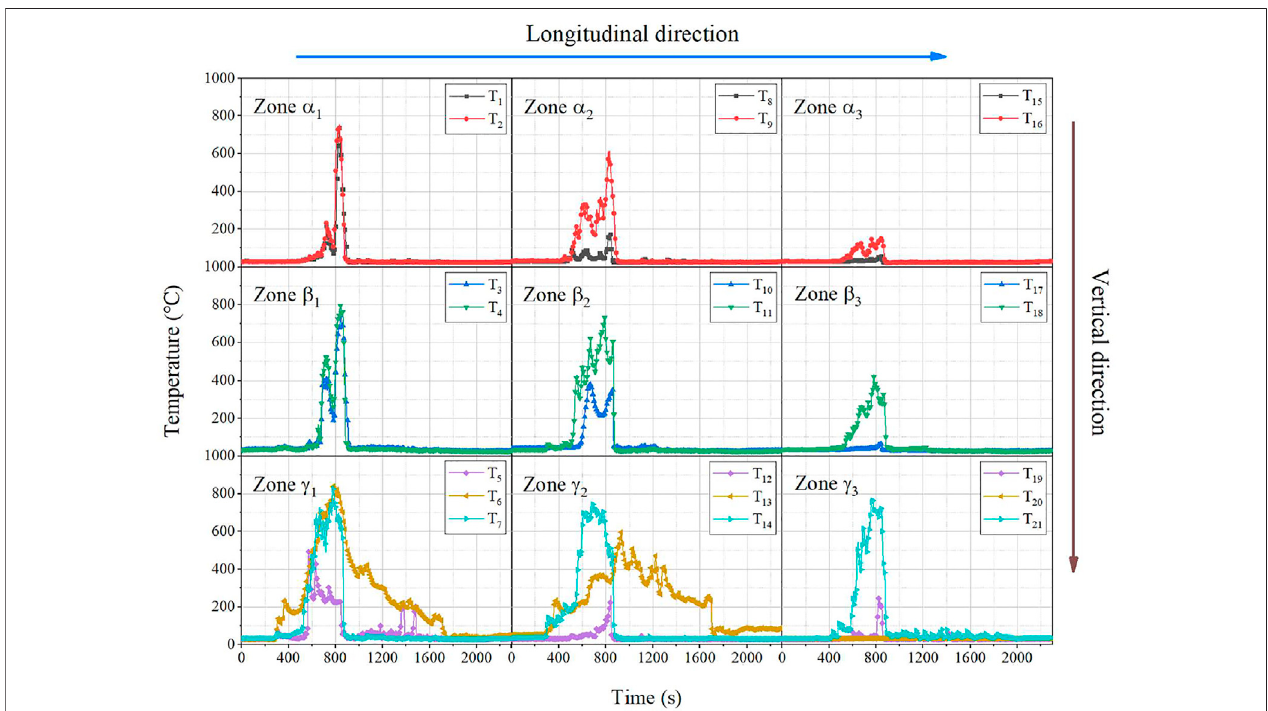
FIGURE 7 | Temperature curves outside the PHEV in test 1.